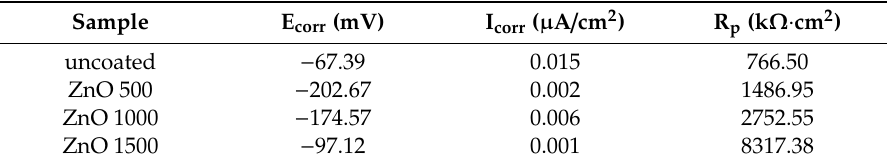
Table 1. Values obtained during potentiodynamic investigations.